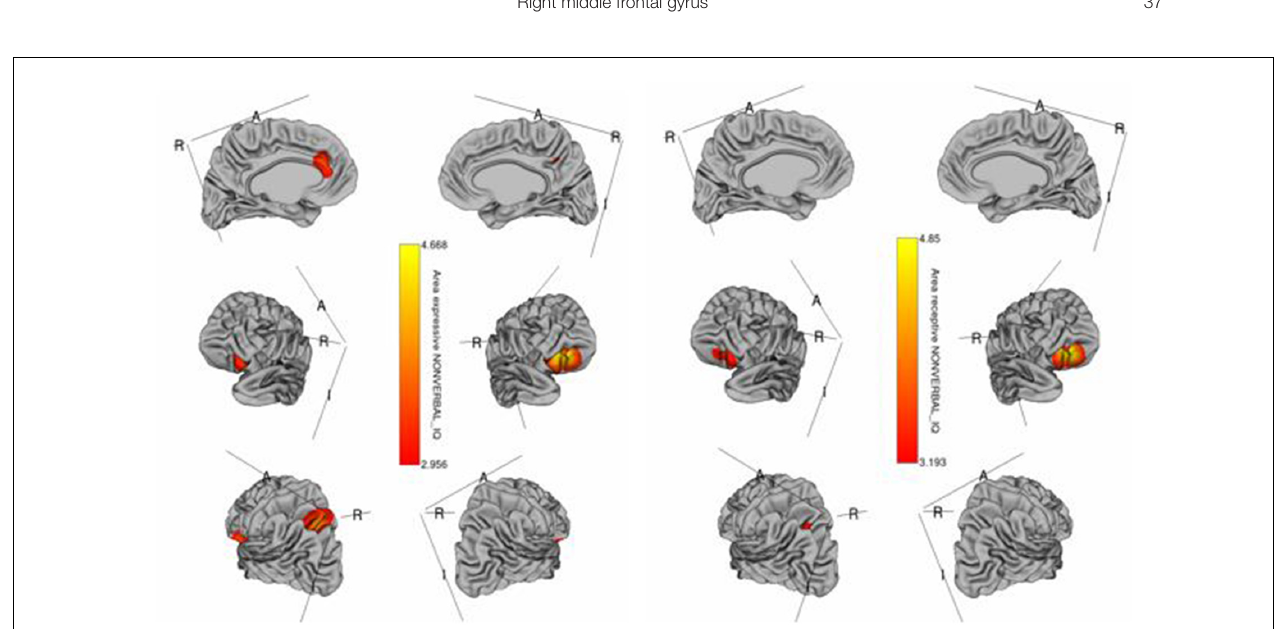
FIGURE 1 | Brain regions where the cortical area is significantly associated with receptive (right) and expressive (left) language scores across diagnostic groups. Colored vertices depict t -statistics for the effect of the cortical area in vertex the specific regression where the vertex was significant after false discovery rate (FDR)